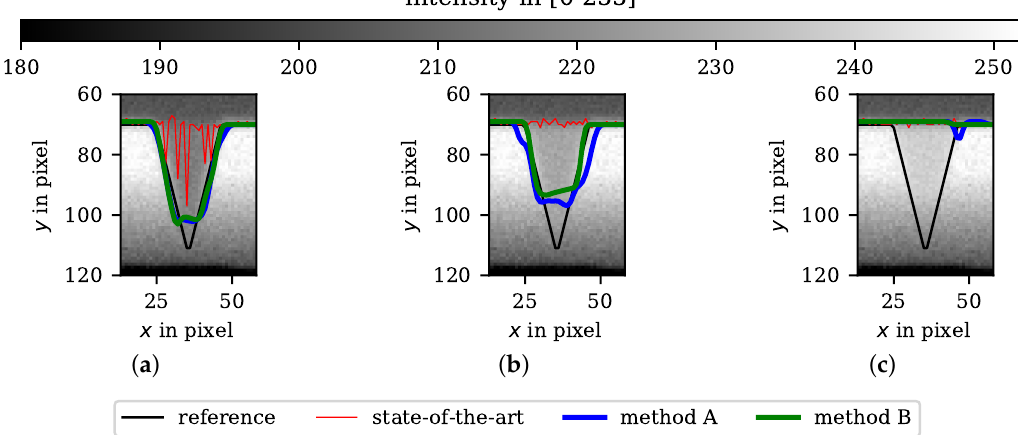
Figure 8. Simulated thermographic flow visualization image with premature flow transitions along the flanks of a turbulence wedge. The relative contrast c wed between the turbulence wedge and the surrounding laminar flow regime is ( a ) 75%, ( b ) 50%, and ( c ) 25%. In contrast to the state-of-the-art method, the introduced image processing methods A (blue) and B (green) are able to detect the turbulence wedge with a c wed of 50%, see panel ( b ). A relative contrast of 25% is too low and results in no detected premature flow transitions for all image processing methods, and therefore the turbulence wedge remains undetected, see panel ( c